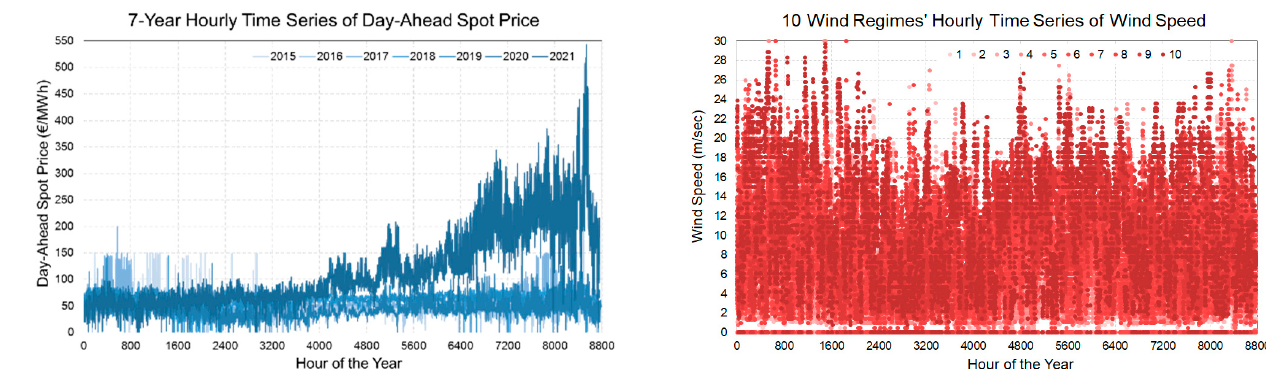
Figure 1. Examined time series of historical electricity prices and wind speed.